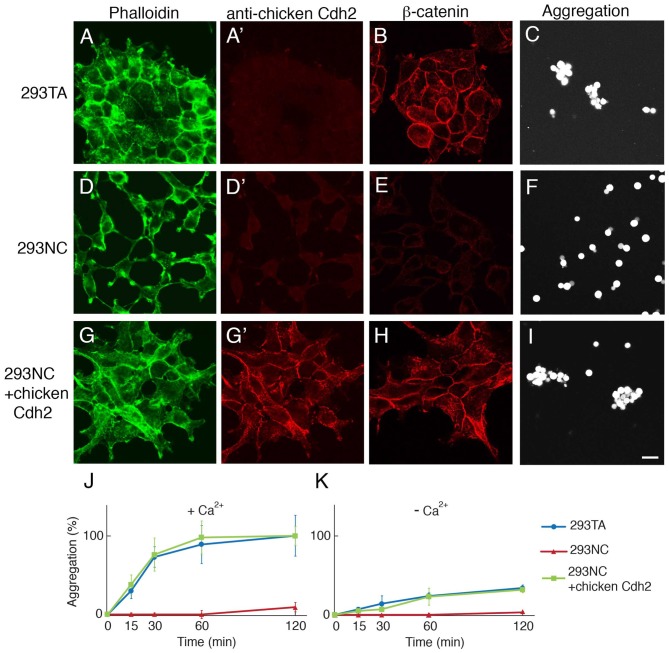
CRISPR-mediated knock-out of cdh2 from 293TA cells. (A–C) Parental 293TA cells proliferate as clusters since cadherin-mediated lateral adhesion is active as revealed by phalloidin-stained cytoskeletal actin (A). These human cells were not stained with anti-chicken Cdh2 antibody (A′) but did express human Cdh2 (see Supplementary Figure S1E). β-catenin, a cadherin-associate cytosolic protein, is concentrated at cell contacts (B). After dissociation and incubation for 30 min, 293TA cells form aggregates (C). (D–F) 293NC cells, generated by mutation of both alleles of the cdh2 gene. 293NC cells grew as isolated cells with minimal spreading (D). They lost immunoreactivity for β-catenin (E) and failed to aggregate (F). (G–I) 293NC cells transfected with a full-length chicken Cdh2 construct recovered lateral adhesions (G). Chicken N-cadherin accumulated at cell-cell contacts (D′,G′), β-catenin was concentrated at the cell surface (H) and aggregation was rescued (I). Bar, 20 μm. (J, K) Quantification of cell aggregation in the presence (J) or absence (K) of extracellular calcium (1 mM), from experiments such as those shown in (C,F,I; Mean ± SEM, n = 10). Significance of differences at 60 min and 120 min, p < 0.005 by Student’s t-test between 293TA and 293NC, and 293NC and 293NC+chicken Cdh2 in (J), and p < 0.01 between 293TA and 293NC, and 293NC and 293NC+chicken Cdh2 in (K).